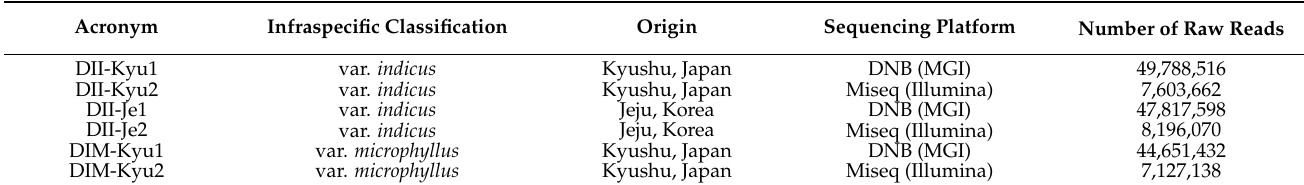
Table 1. The sequencing information of six individuals of Damnacanthus indicus .